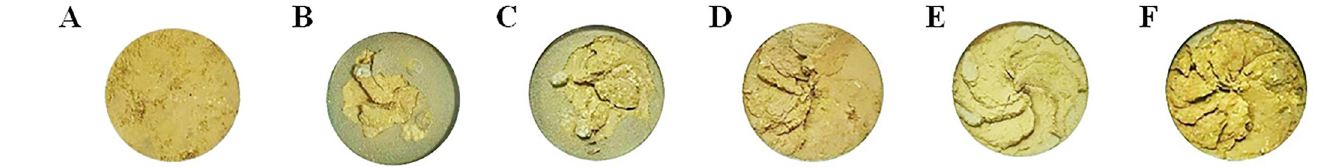
Fig 14. Comparison of the shear surface morphology of 4 # , 7 # - 10 # undisturbed loess specimen before and after the test shearing ( w = 16%). (A) Before specimen. (B) 7 # σ = 100 kPa. (C) 8 # σ = 200 kPa. (D) 9 # σ = 400 kPa. (E) 4 # σ = 800 kPa. (F) 10 # σ = 1200 kPa.